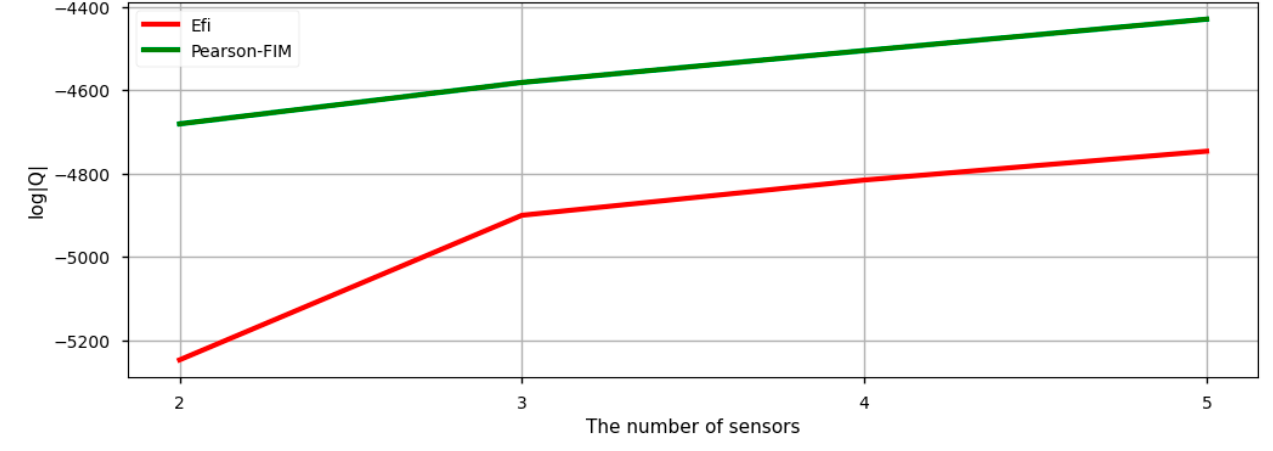
Figure 11. Determinants of Fisher information matrix derived from reduced candidate